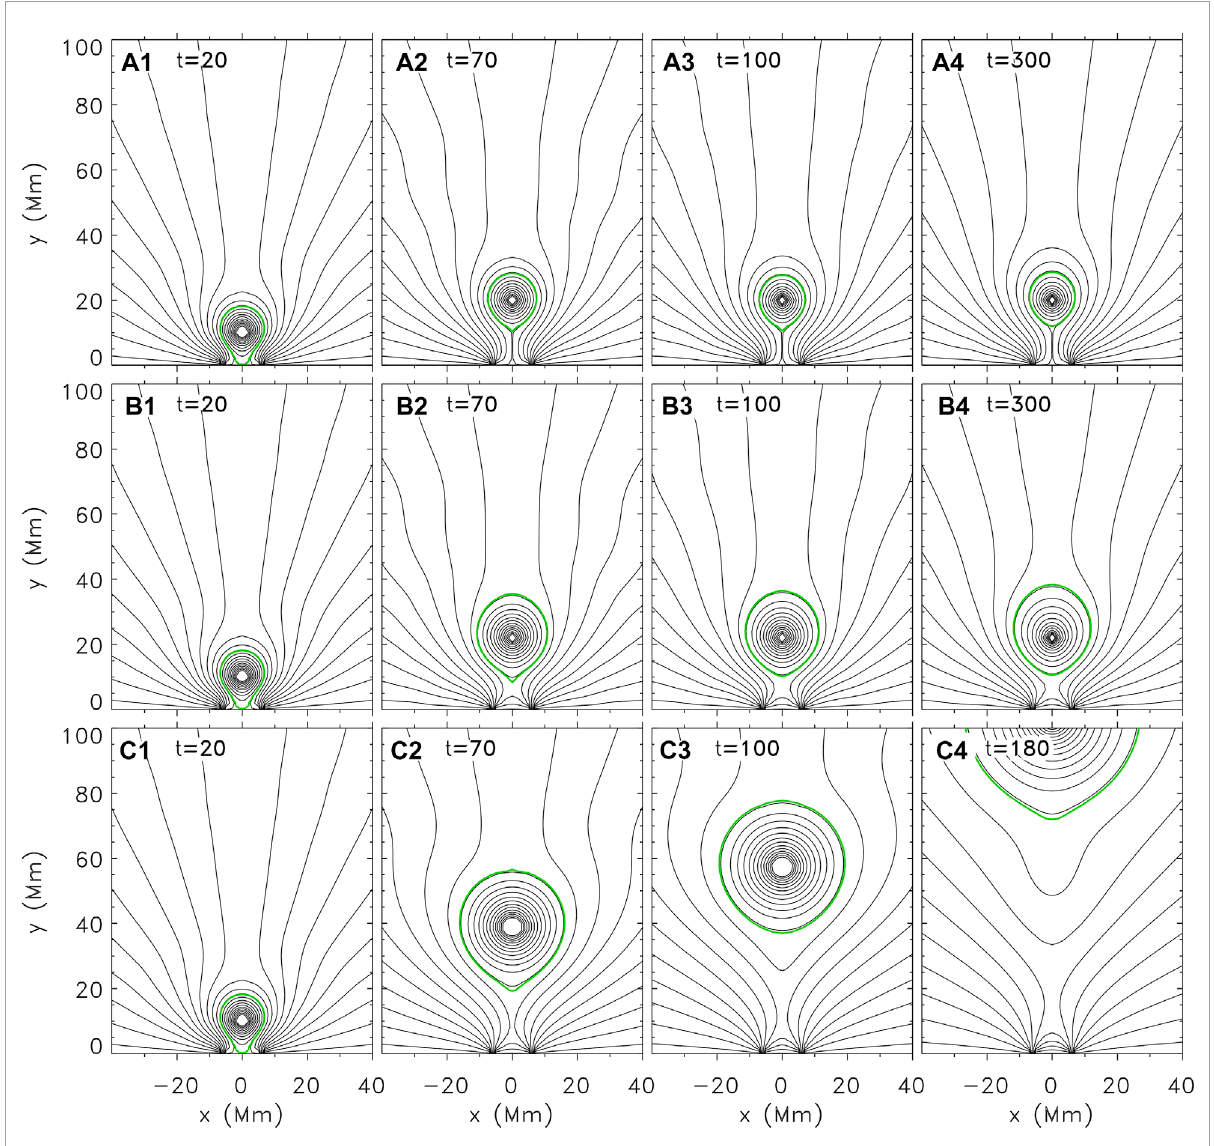
FIGURE 3 The temporal evolutions of the flux rope for Case II. Panels (A1–A4) illustrate the evolution of the flux rope during the relaxation to simulate the equilibrium state in Figure 2G . Panels (B1–B4) illustrate the evolution of the flux rope during the relaxation to simulate the equilibrium state in Figure 2K , which is the equilibrium state right before Φ z = Φ w zc is reached under the resistive condition; Panels (B1–B4) illustrate the evolution right after Φ z = Φ w zc is reached under the resistive